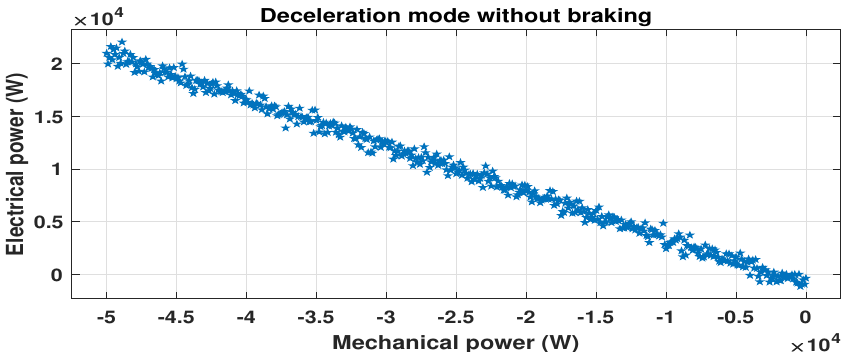
Figure 10. Efficiency of electric vehicle in deceleration mode without using braking